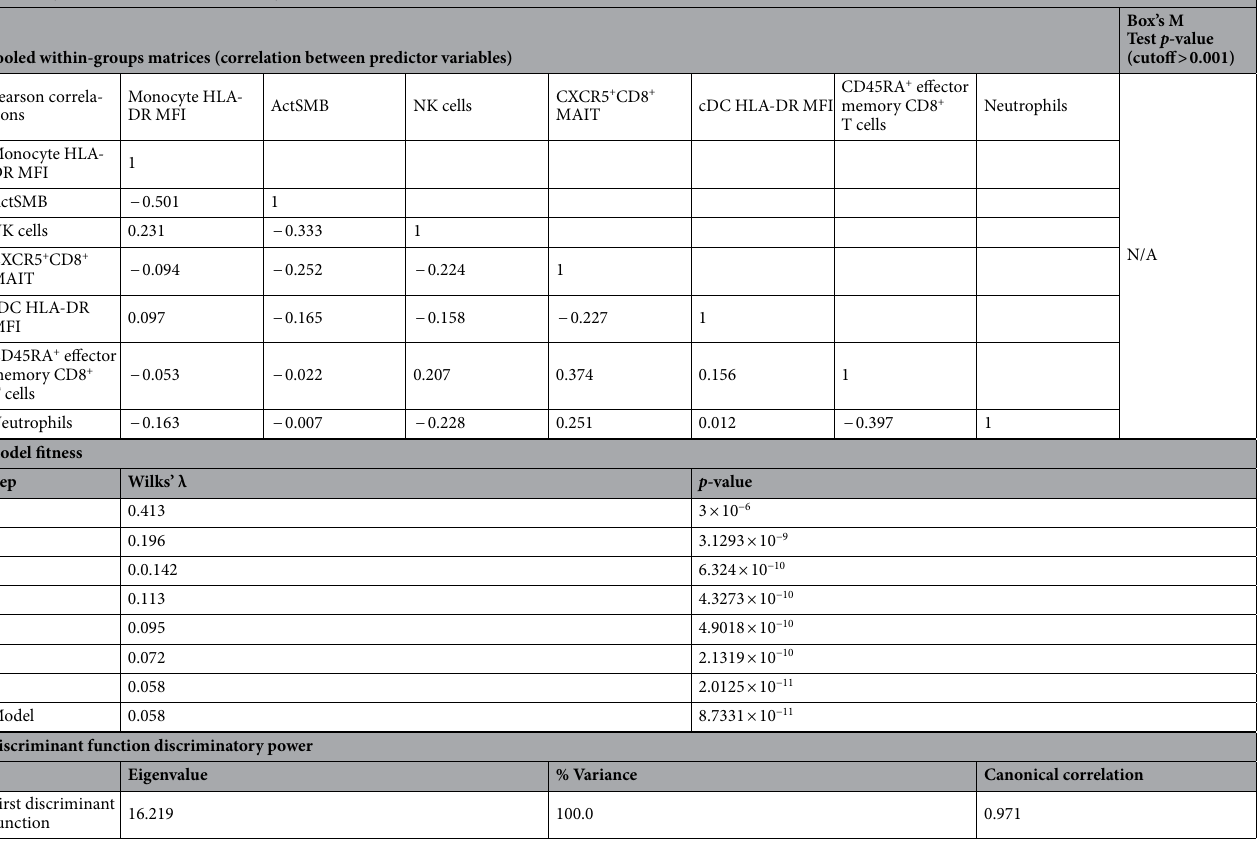
Table 1. Evaluation of the fitness of the discriminant models and the relative importance of canonical functions within each model. Model variables were sequentially incorporated into the model, one at a time, and are listed in the order they were incorporated. NK cells natural killer cells, en27NK CD27 + NK